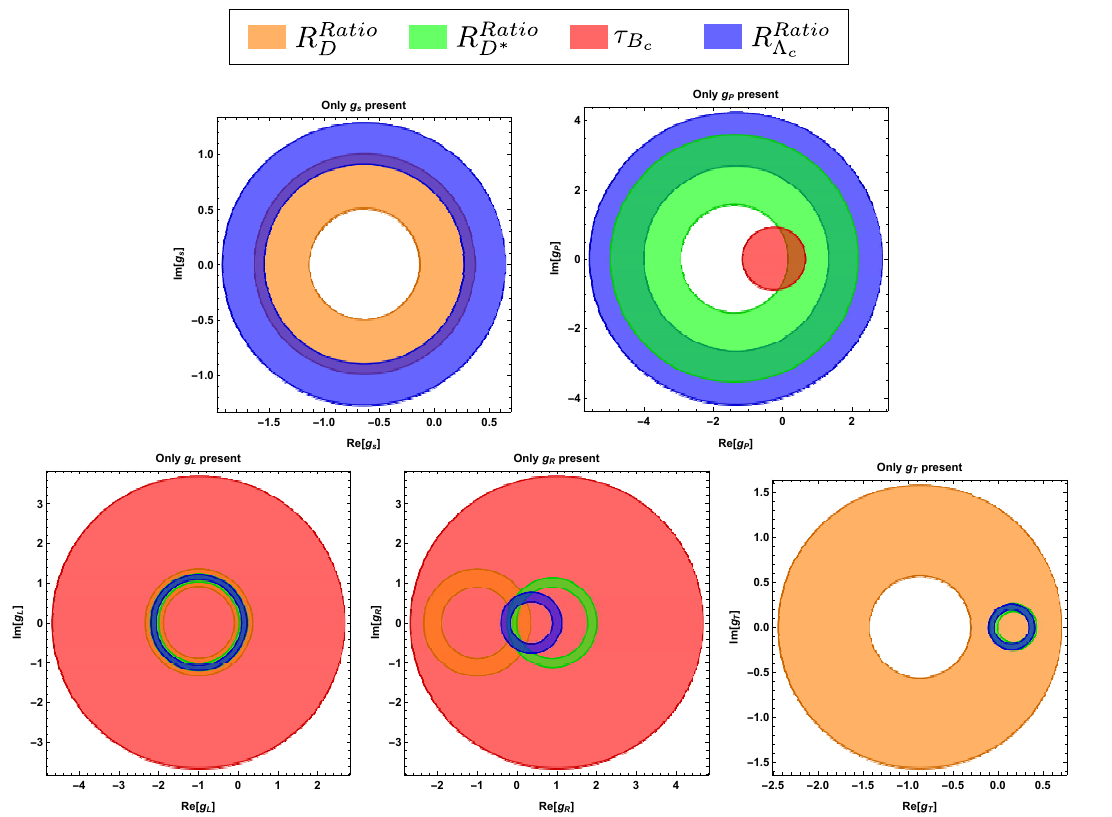
Figure 6 . Constraints on individual new-physics couplings from a possible R (Λ c ) measurement (shown in blue), assuming that R Ratio are the mesonic constraints as in figure